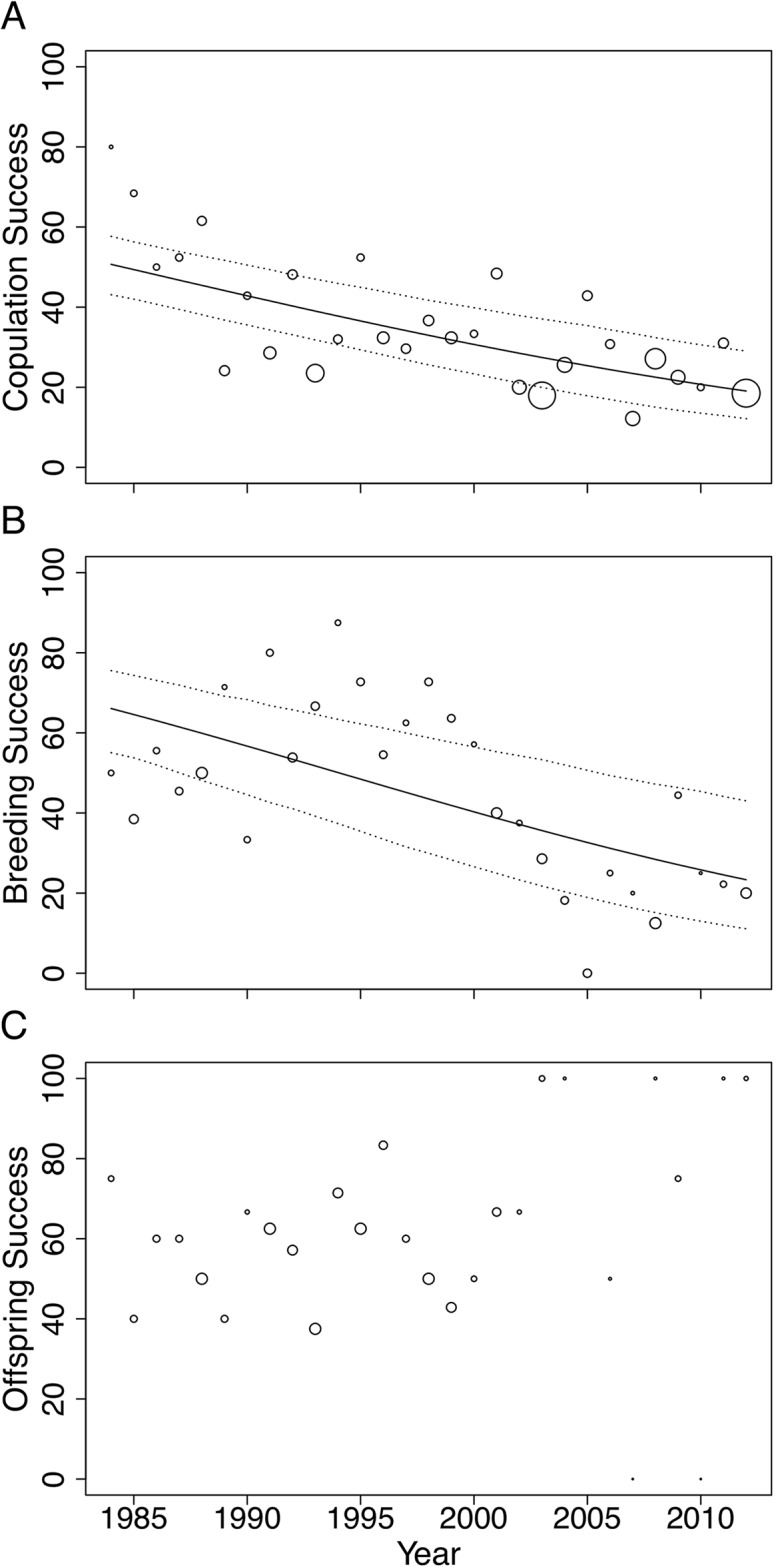
Changes in (A) copulation success, (B) breeding success and (C) offspring success rates of the San Diego Zoo koala population over time (n = 29 years).Changes were modelled using GLMs with binomial distribution. Trend lines are plotted for copulation success (ß = −0.05, SE = 0.009, p < 0.001) and breeding success (ß = −0.07, SE = 0.015, p < 0.001). Dotted lines represent 95% CI obtained by parametric bootstrapping of the intercept and slope. Point size correlates to number of pairings, number of copulations and number of offspring in (A), (B) and (C), respectively.